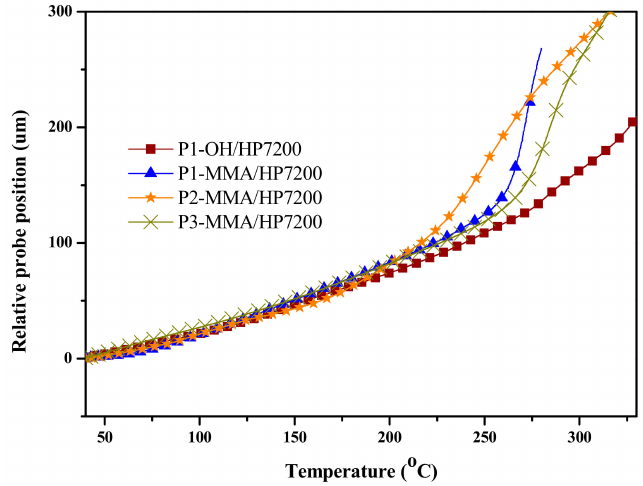
Figure 9. TMA thermograms of prepared